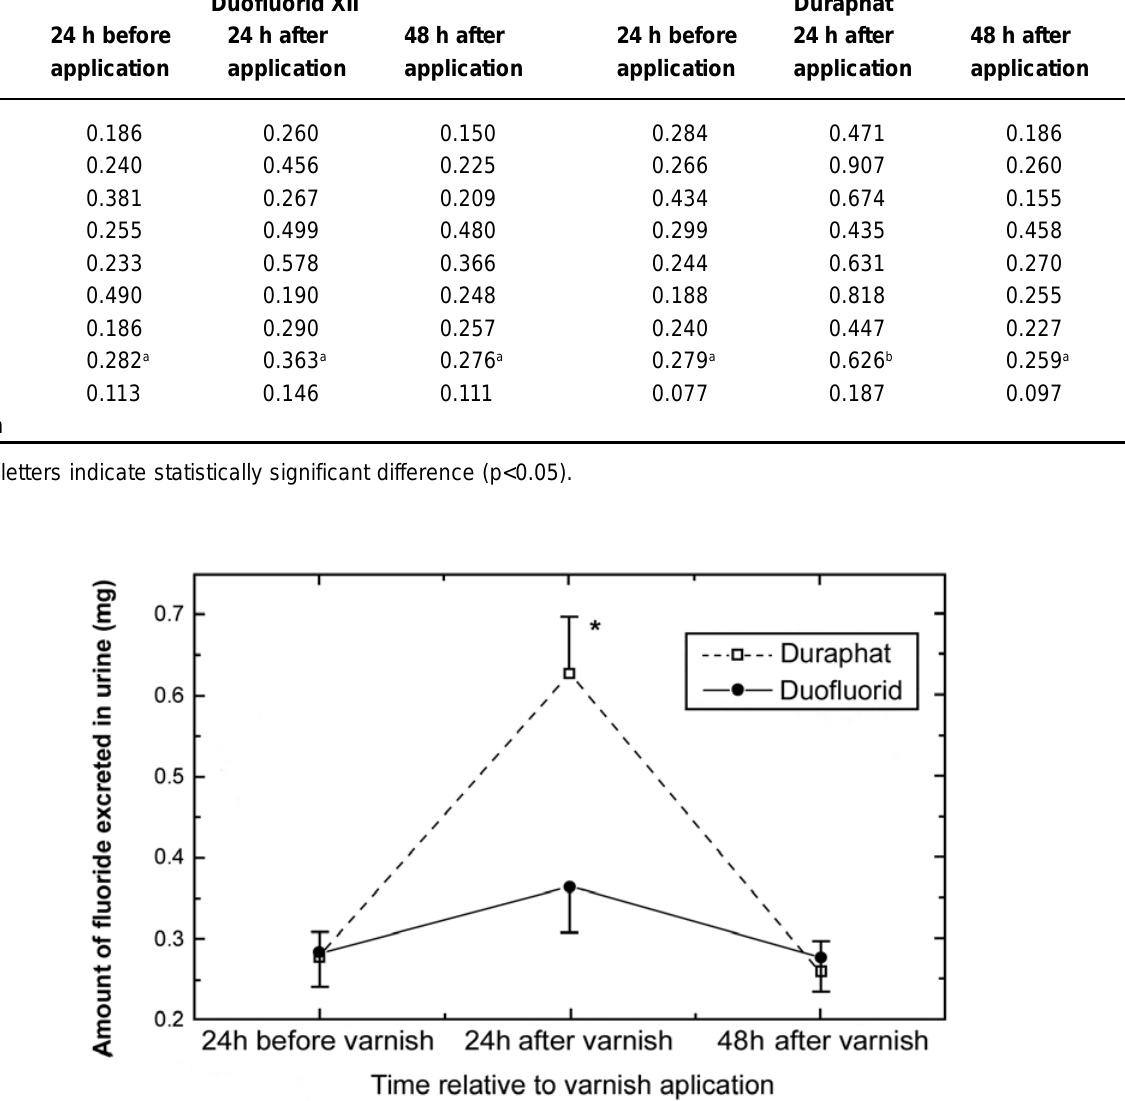
TABLE 1- Individual and mean amount of fluoride excreted (mg/day) in urine before and after application of Duofluorid XII TM and Duraphat TM varnishes